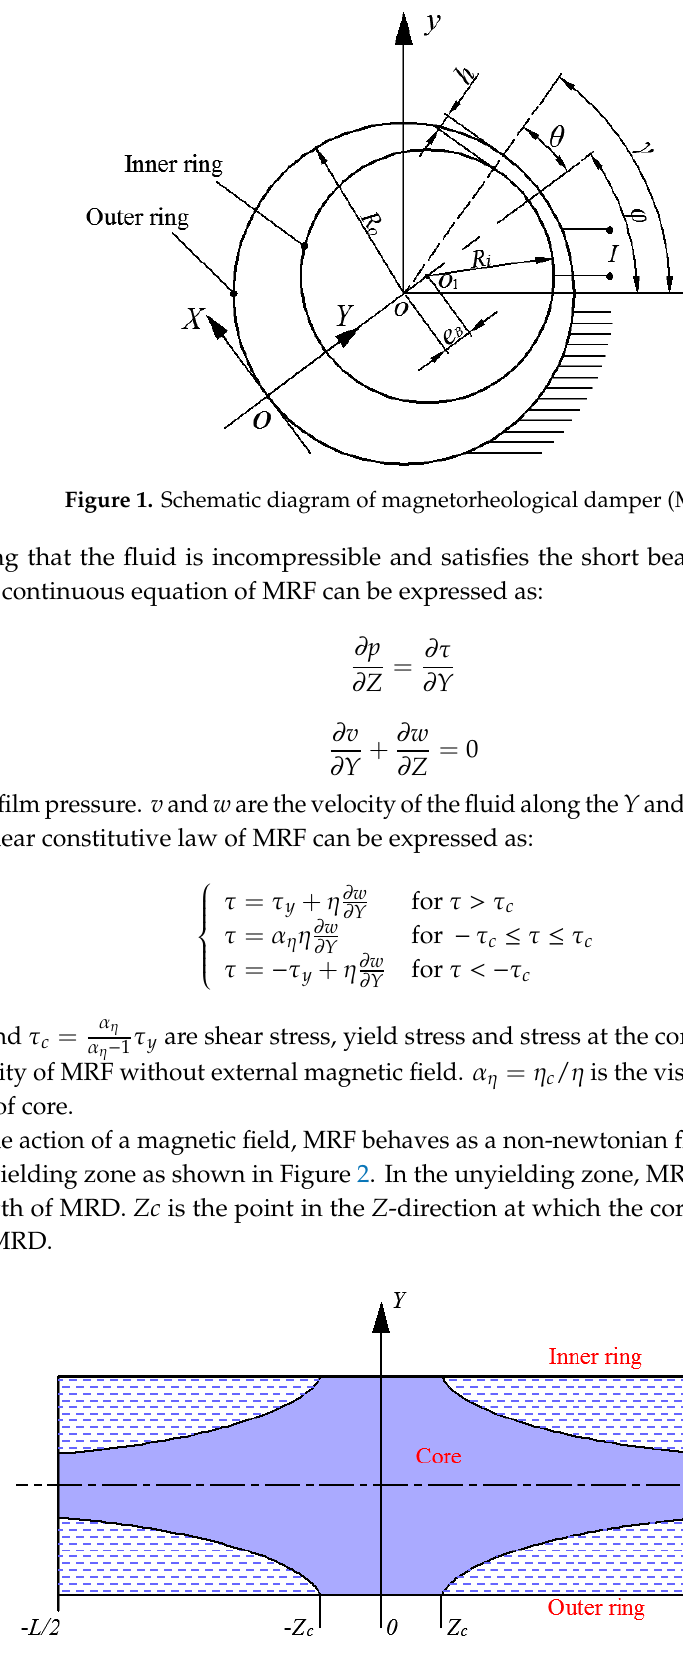
Figure 2. State characteristic of magnetorheological fluid (MRF) in the clearance of MRD.